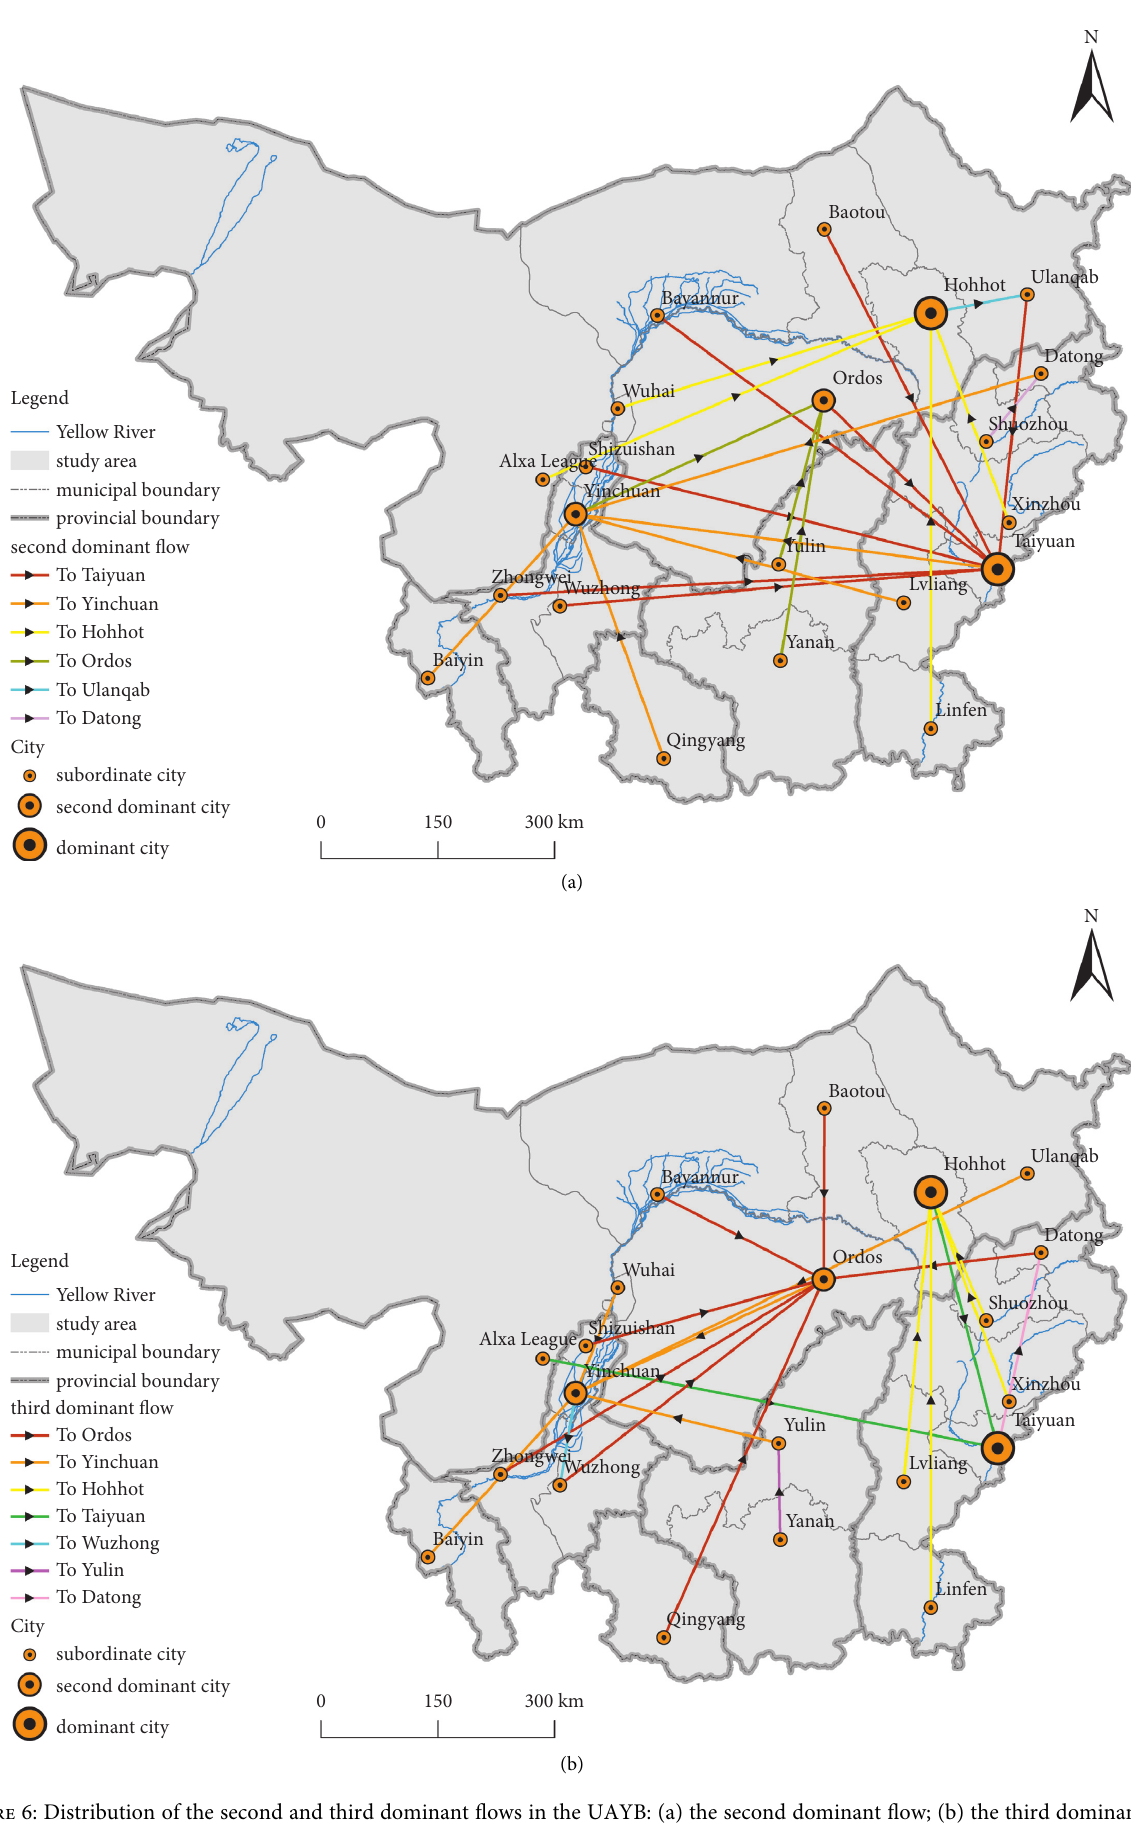
Figure 6: Distribution of the second and third dominant flows in the UAYB: (a) the second dominant flow; (b) the third dominant